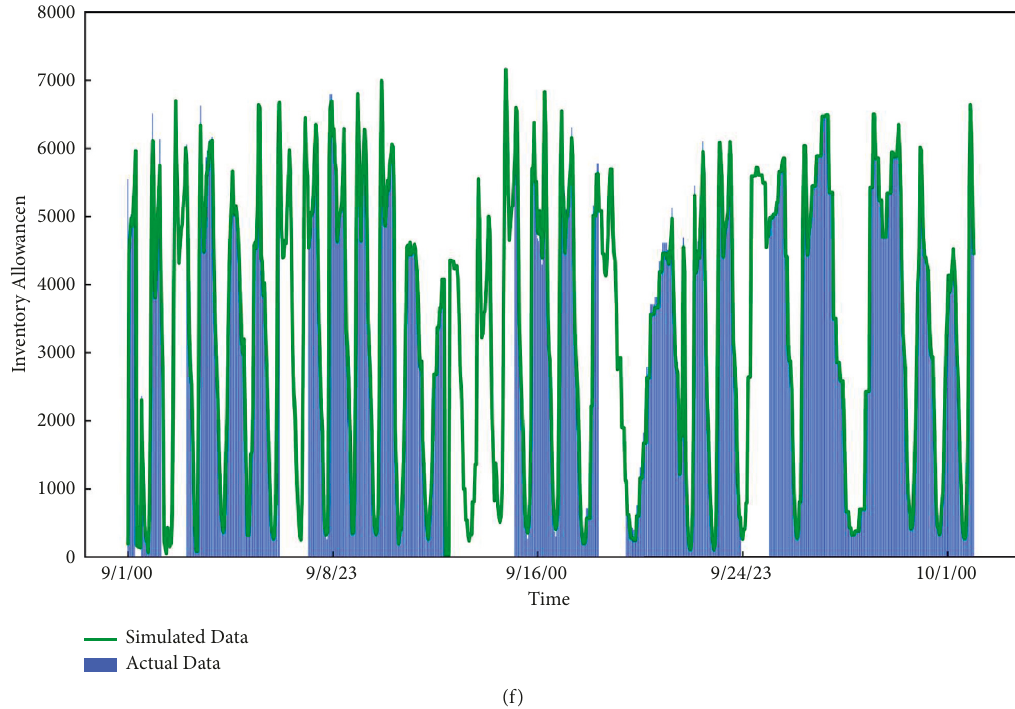
Figure 4: Compare the results of the models: (a) TRMF, (b) BTMF, (c) BPMF, (d) BTRMF, (e) LSTM-ReMF, and (f) LSTM-GL-ReMF. Table 1: Table of values for each parameter. Parameters Values Missing rates/%